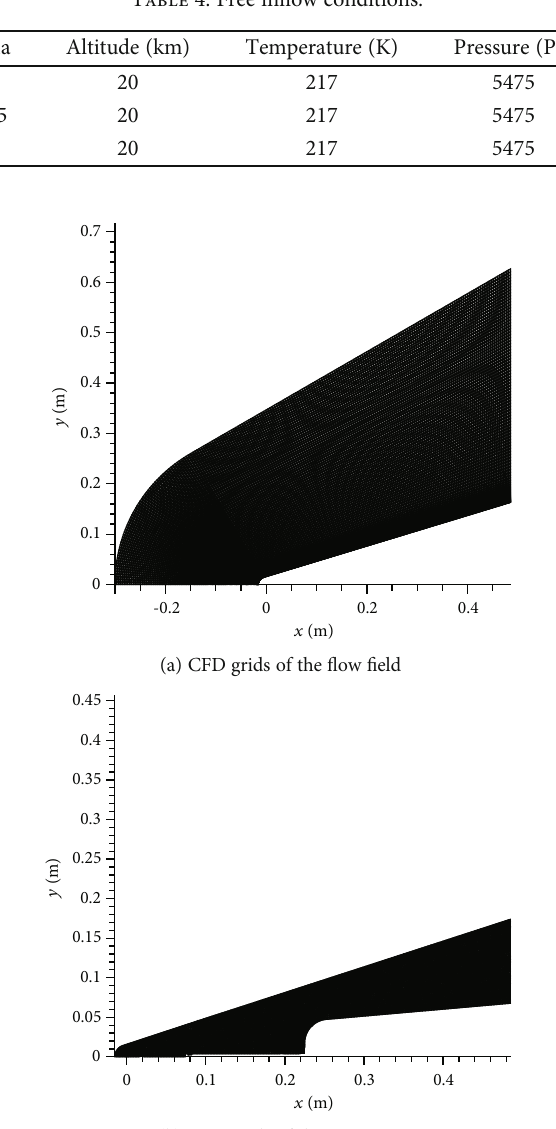
Table 4: Free in fl ow conditions.